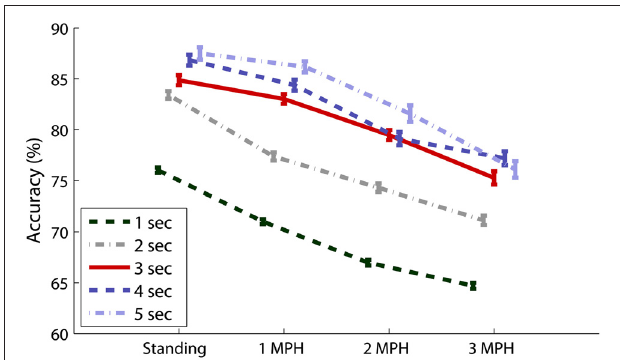
FIGURE 5 | Eight-ch CCA-based SSVEP detectability using different epoch lengths (1–5 s) under different walking speeds. The error bars represent the standard error of the